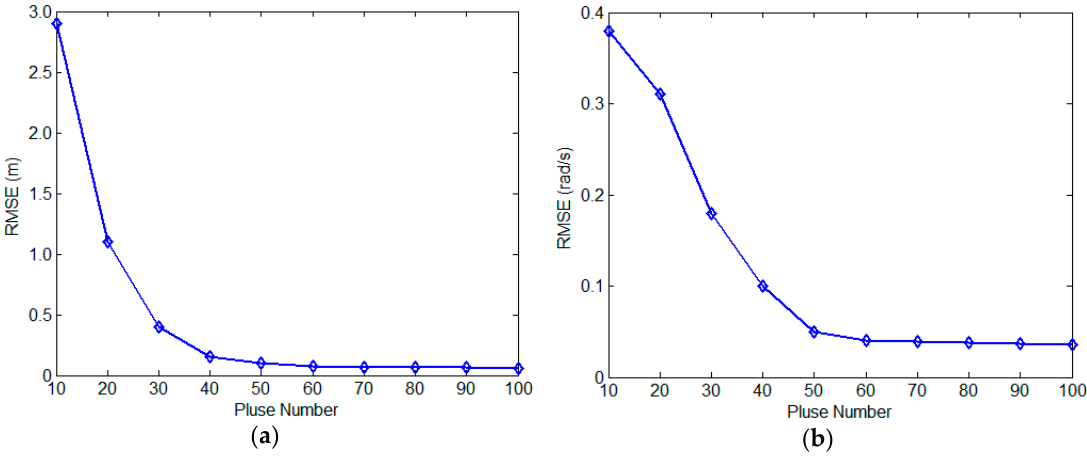
Figure 10. RMSE against pulse number. ( a ) 3D geometry; ( b ) spinning angular velocity.